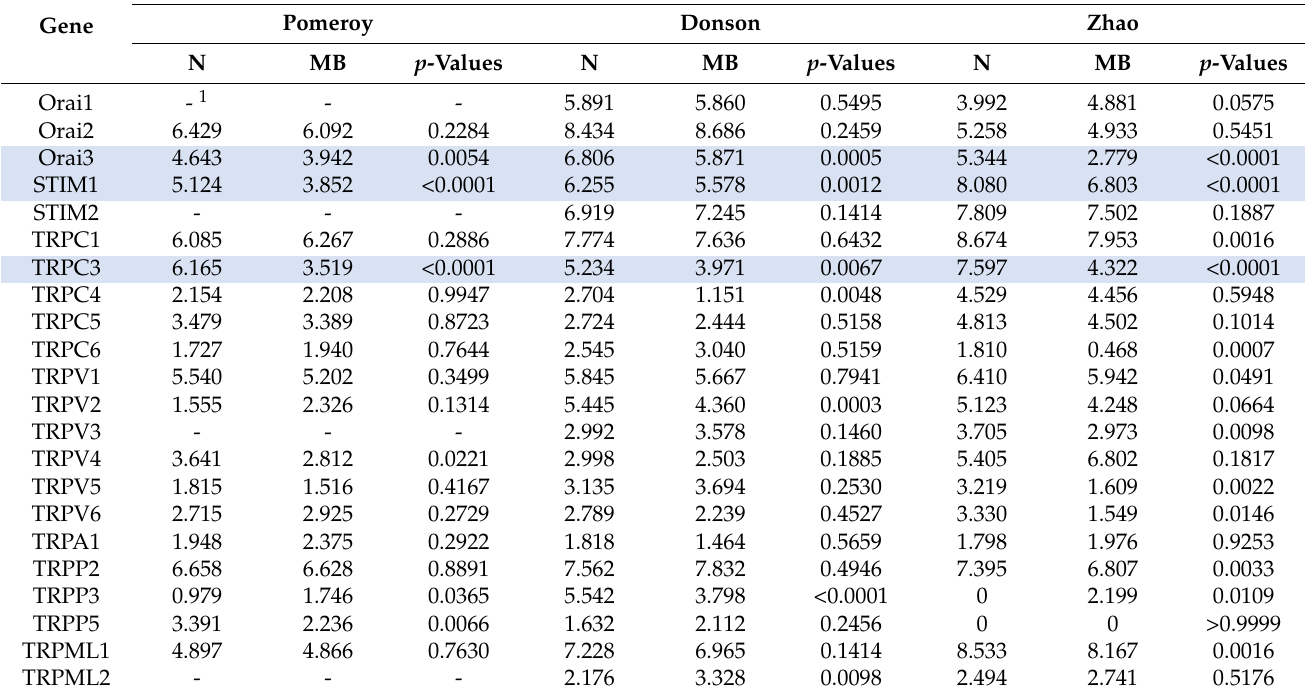
Table 2. The average mRNA (log 2) expression and p -values of Ca 2+ transporter genes in MB patient tumour tissues and normal brain tissues (N) in three independent datasets; Pomeroy [17], Donson [18], and Zhao [19]. Highlighted genes in blue show significantly lower expression in MB tissues (compared to normal brain tissue) in all the three datasets, whilst genes highlighted in red, higher expressed genes. The p -values were calculated through a two-tailed unpaired non-parametric t -test (Mann-Whitney test). A p -value of less than 0.01 was set as a cut-off for statistical